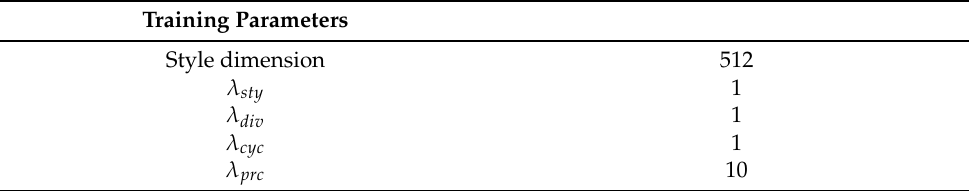
Table 1. Parameters employed during